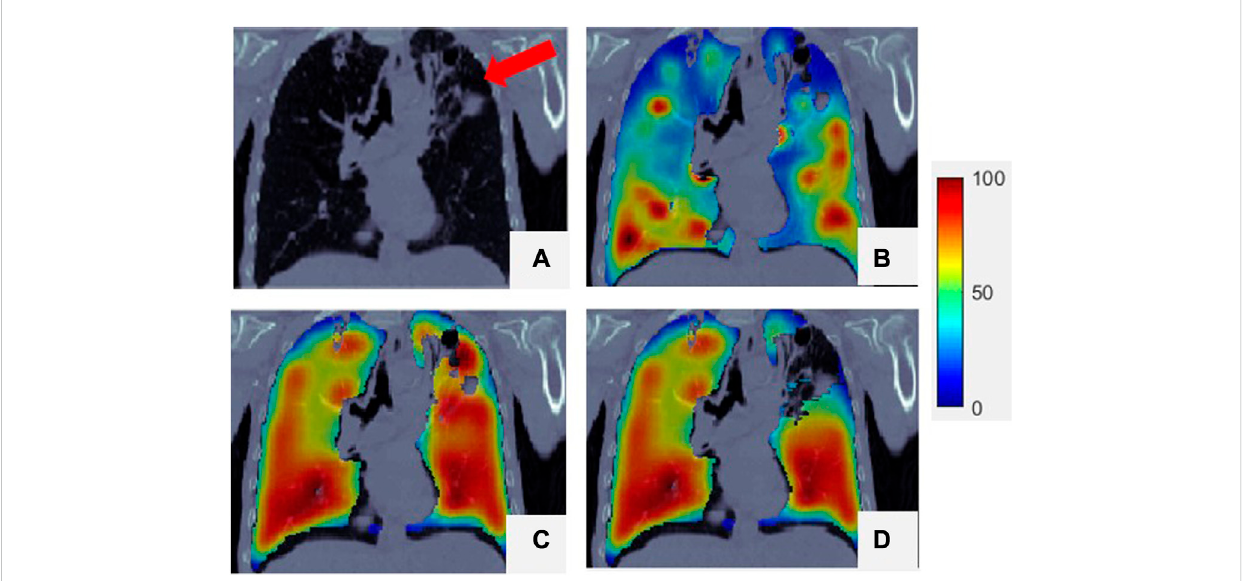
FIGURE 5 Comparison of SPECT image and CTVI SVD images for arepresentative case. (A) Is CT; (B) isthe SPECT of thelung region superimposed ontothe CT; (C) is the origin CTVI SVD of the lung region superimposed onto the CT; (D) is the corrected CTVI SVD of the lung region superimposed onto the CT. For all the fi gures, their 99th percentile and higher values were scaled to 100, and the minimum value was scaled to 0.